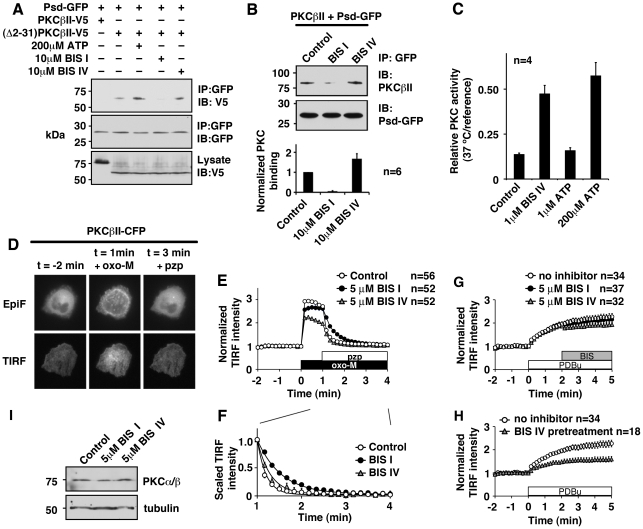
BIS compounds change how the pseudosubstrate domain interacts with PKC.(A) Immunoprecipitation from cell lysates expressing the pseudosubstrate domain fused with GFP (Psd-GFP) and V5 tagged wild-type PKCβII or the pseudosubstrate domain deleted PKCβII, (Δ2-31)PKCβII. The binding conditions are indicated. (B) In vitro binding between Psd-GFP and purified PKCβII in the presence of PDBu. Lower panel shows quantification from independent experiments. (C) Thermal stability of purified PKCβII in indicated conditions. Four independent experiments of triplicates are summarized. (D) Subcellular localization of CFP tagged PKCβII, PKCβII-CFP. Epifluorescent (EpiF) and TIRF (TIRF) images were collected sequentially from the same cell. Focal application of 300 nM oxo-M induced translocation of PKCβII-CFP, which was terminated by 100 µM pirenzepine (pzp). (E) Quantification of PKCβII-CFP localization by TIRF intensity from control (open circles), 5 µM BIS I (closed circles) or 5 µM BIS IV (grey triangles) treated cells. Application of oxo-M (black box) and pirenzepine (pzp, open box) are indicated. (F) Scaled time courses from (E) showing the deactivation process after application of pirenzepine. (G) Effects of BIS compounds on membrane location of activated PKCβII-CFP. The boxes indicate the presence of 100 nM PDBu (white) and BIS compounds (grey). No inhibitor (open circles), 5 µM BIS I (closed circles), 5 µM BIS IV (grey triangles) are indicated. (H) PDBu induced translocation of 5 µM BIS IV pretreated cells (grey triangles). No inhibitor control (open circles) is the same as in panel (G). (I) Immunoblots of PKCα/β and tubulin after two-hour treatments with 5 µM BIS I and 5 µM BIS IV. Tubulin is shown as a loading control.